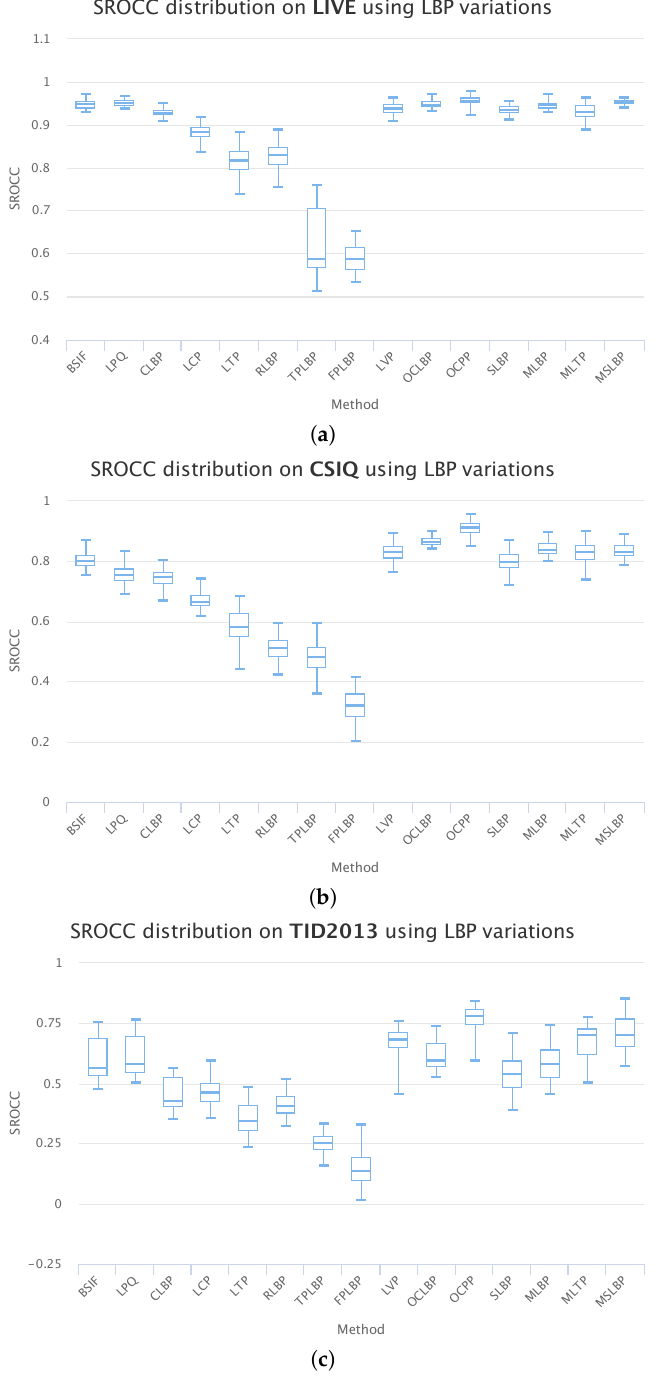
Figure 26. Distribution of average SROCC after 100 simulations using different LBP variations. ( a ) LIVE2. ( b ) CSIQ. ( c )